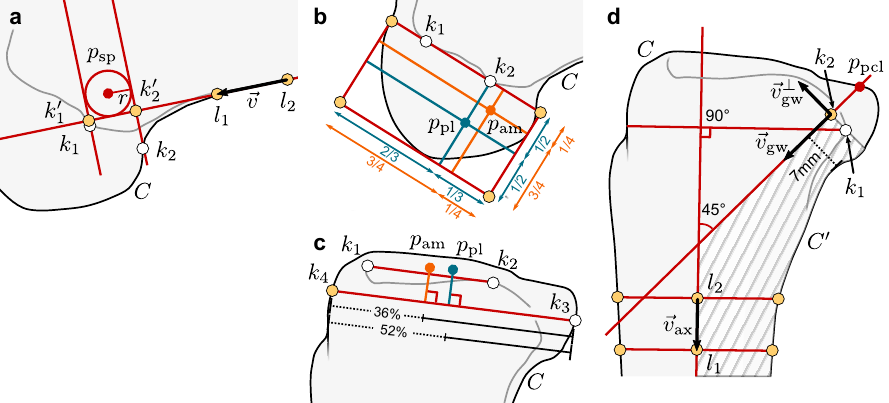
Figure A2. Geometric relations of the considered surgery planning types. ( a ), MPFL. ( b,c ), femoral and tibial ACL. ( d ),